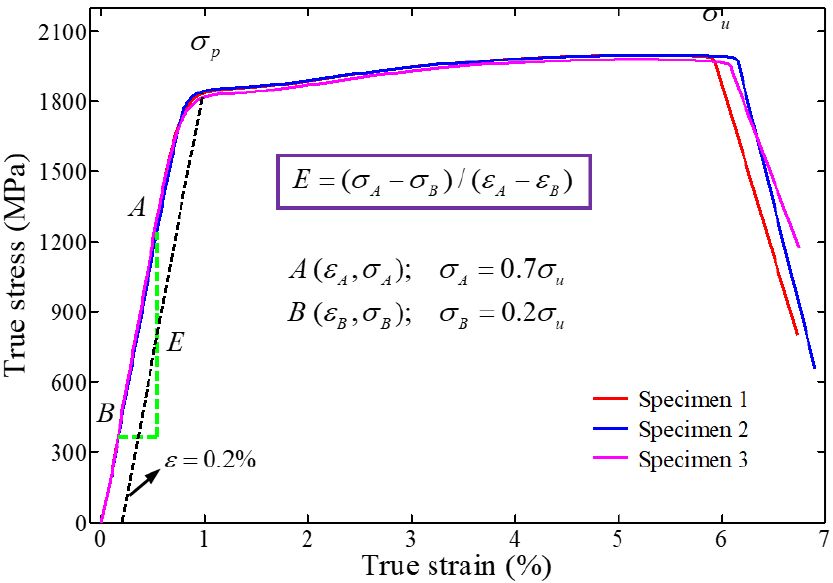
× steel strand according to code GB/T 288.1 B30 [35].